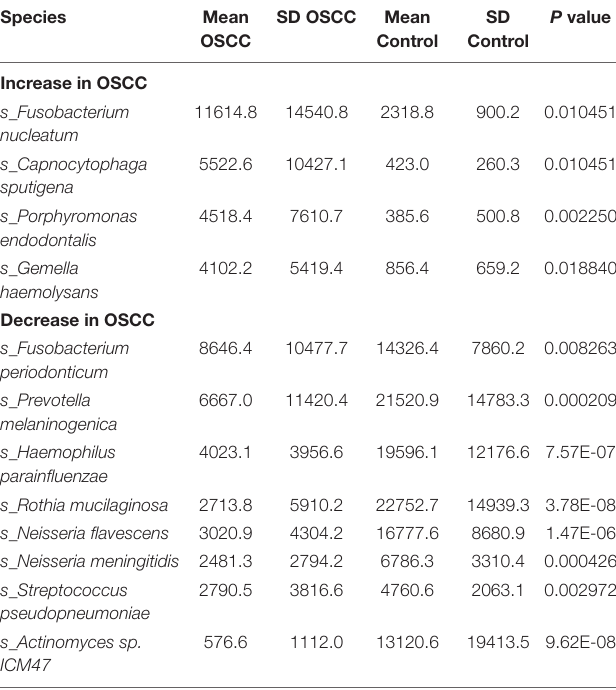
TABLE 2 | Significant changes in species between the two